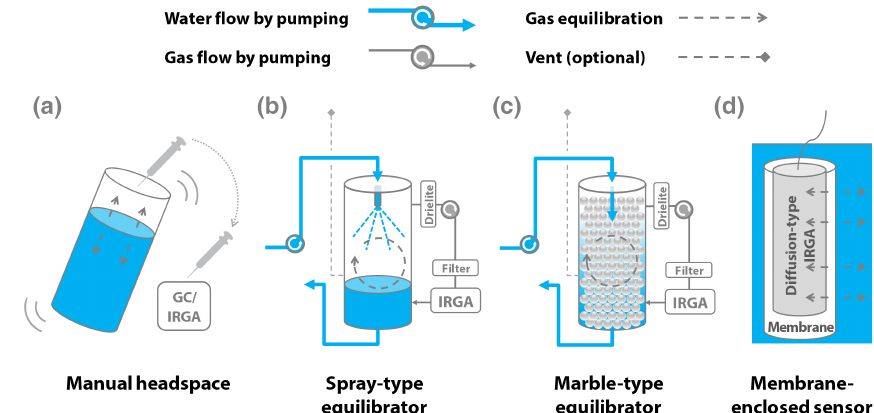
Figure 1. Schematic diagrams of four equilibration methods: (a) manual headspace equilibration, (b) spray-type equilibrator, (c) marble- type equilibrator, and (d) membrane-enclosed sensor. Refer to Table 1 for descriptions of basic operation principles, and Figs. S1 and S2 for pictures showing the three gas equilibration systems employed during field